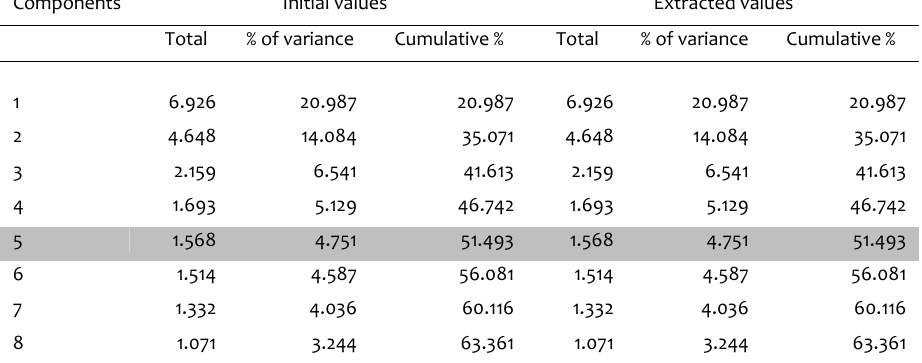
Table 2: Factor analysis of the data Components Initial values Extracted values